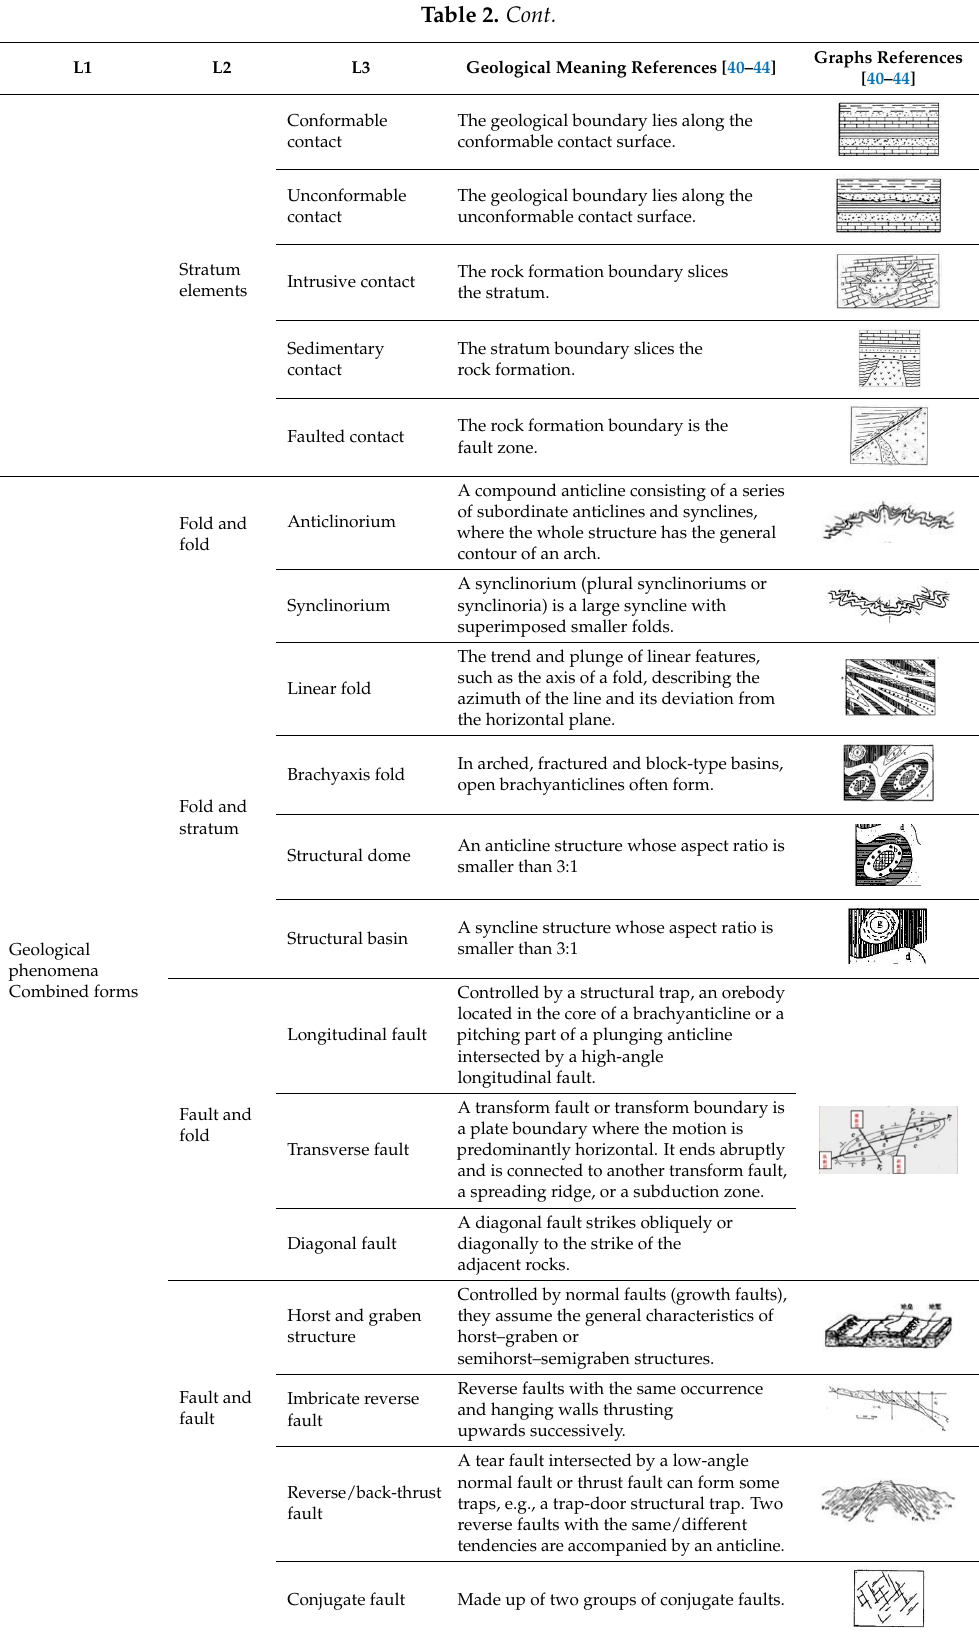
traps, e.g., a trap-door structural trap. Two reverse faults with the same/different tendencies are accompanied by an anticline. Conjugate fault Made up of two groups of conjugate faults. In a strike-slip fault (also known as a wrench fault, tear fault or transcurrent fault), the fault surface (plane) is usually Strike-slip fault nearly vertical, and the footwall moves laterally (i.e., sinistrally or dextrally) with very little vertical motion. Dip-slip faults can be either normal (extensional) or reverse. In a normal fault, Fault and the hanging wall moves downward relative stratum Dip-slip fault to the footwall. A reverse fault is the opposite of a normal fault, i.e., the hanging wall moves up relative to the footwall. Oblique